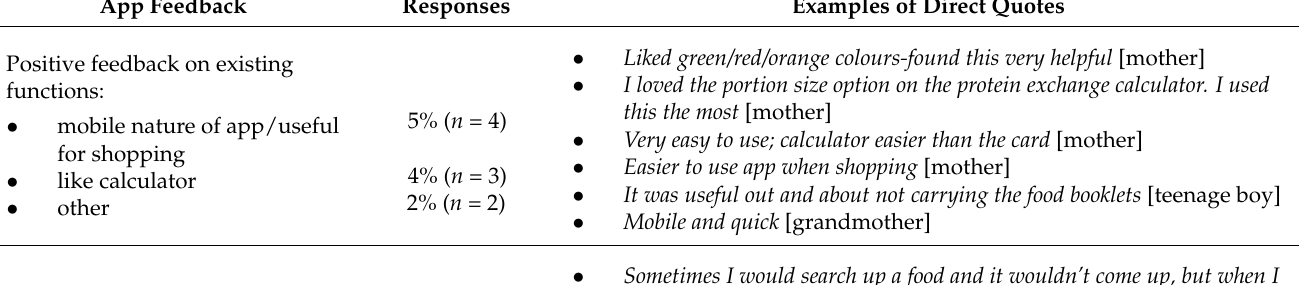
Table 11. Feedback about ‘ PKU Bite ’ ®